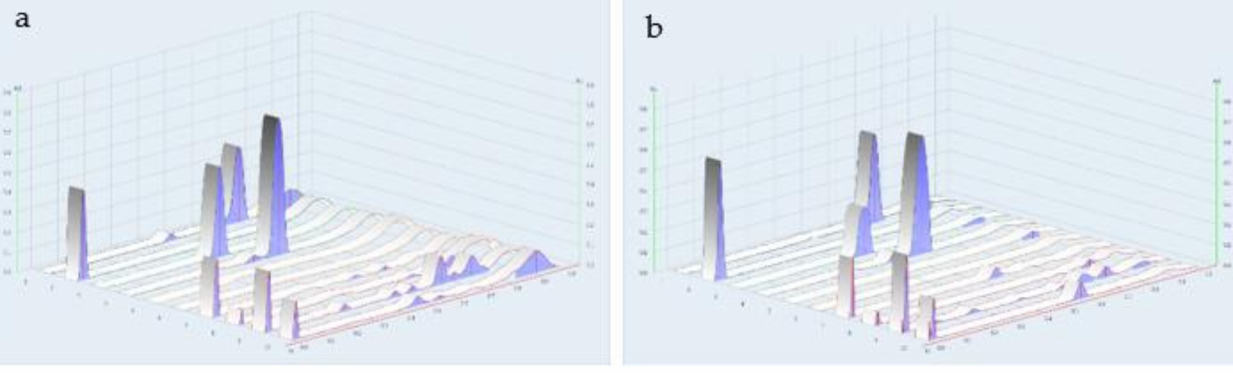
Figure 7. Densitograms of water extract of TS remedy. ( a ) UV at 254 nm; ( b ) UV at 366 nm; (1) kaempferol; (2) rutin; (3) gallic acid; (4) caffeic acid; (5) linalool; (6) cineol; (7) TS remedy; (8) Coriandrum sativum L. extract; (9) Aegle marmelos (L.) Corr ê a extract; and (10) Morinda citrifolia L.